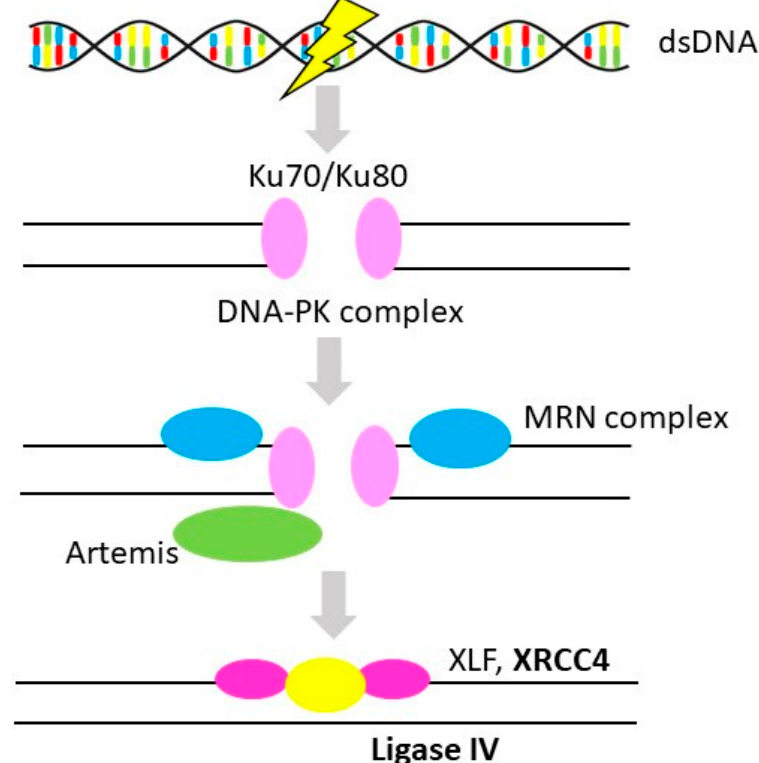
Figure 3. Non-homologous end-joining repair. Simplified scheme of non-homologous end-joining repair of double strand DNA breaks (gene alterations in OvC in bold ) [32]. Protein names: DNA end-binding proteins Ku70/Ku80 (Ku70/Ku80), DNA-dependent protein kinase (DNA-PK), MRE11-RAD50-NBS1 complex (MRN complex), artemis (DCLRE1C), X-ray repair cross complementing-like factor. (XLF), X-ray repair cross complementing 4 (XRCC4), DNA ligase 4 (LIG4) [44].